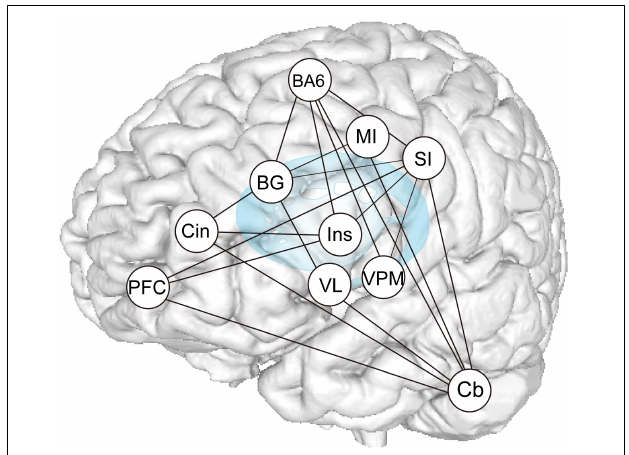
FIGURE 9 | Summary of PPI analysis. Increases or decreases in functional connectivity for dentures in vs dentures out between seed regions within the distributed teeth tapping networks of the brains of elderly adult and areas related to representation, as indicated in the conjunction analysis. The sensory information used to control voluntary actions is processed in pathways that are distinct from the afferent pathways (that contribute to perception). Much oral sensory information may serve to allow for the planning and/or execution of motor acts (teeth tapping). Feedback via the cerebellar loop can be used to correct errors that arise during movement (i.e., essential smooth execution of tapping movements) and feedback via the basal ganglia loop can be used to promote sequential and rhythmical